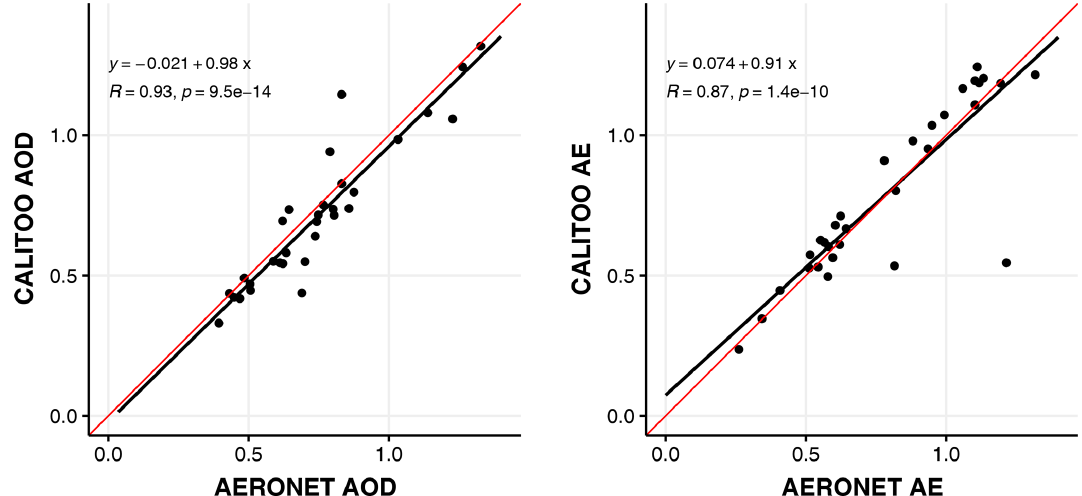
Figure 2. Scatterplot of AOD and AE observed at Lamto by the CALITOO and AERONET instruments between January and March 2017 (number of points = 31).